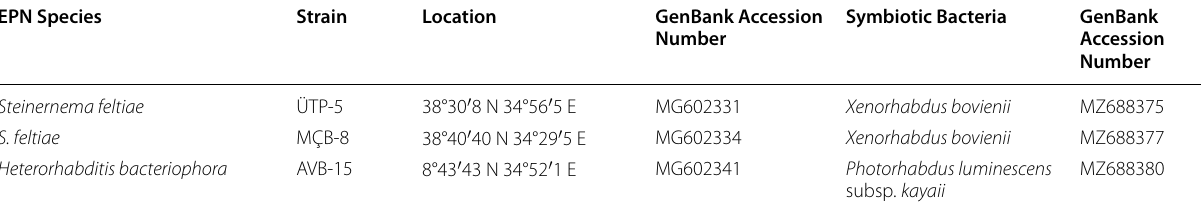
Table 1 Entomopathogenic nematode (EPN) and symbiotic bacterial species used in the pathogenicity bioassays against the different larval instars of Agrotis